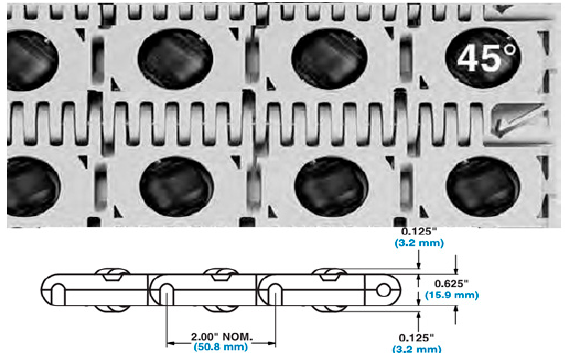
Figure 1. Intralox conveyor Belting Series with 45 ° Angled Roller.